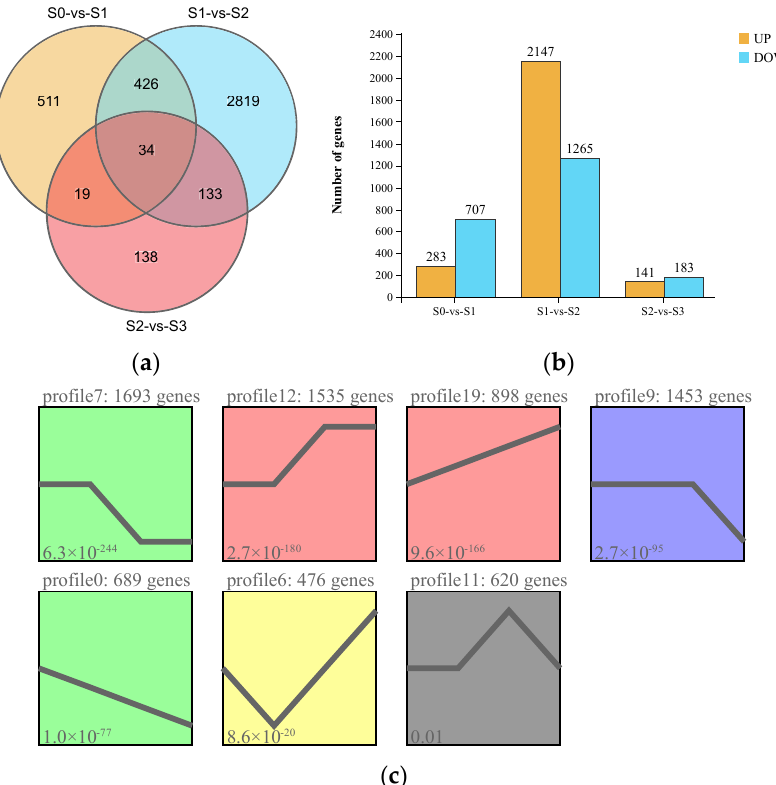
Figure 4. Characterization of differentially expressed genes (DEGs) identified by pairwise comparisons among the four statuses of spike development (S0, S1, S2, and S3; for an explanation, see Figure 1) in Phalaenopsis . ( a ) Venn diagram of the DEG numbers in the three pairwise comparisons (S0 vs. S1, S1 vs. S2, and S2 vs. S3). ( b ) Numbers of upregulated and downregulated DEGs in each pairwise comparison. ( c ) Gene expression patterns of the seven profiles identified by Short Time-series Expression Miner (STEM); different colors indicate different expression patterns ( p ≤ 0.05).